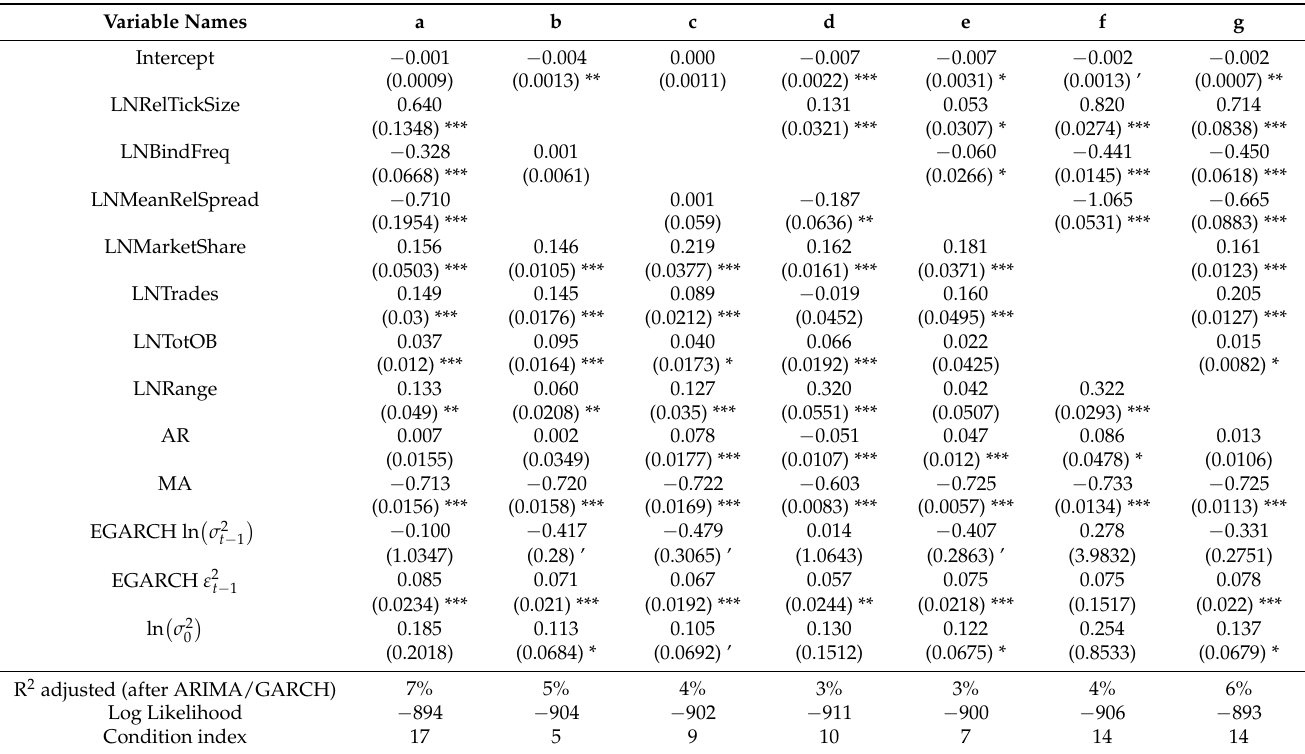
Table 5. Regressions on OIBReversal estimated with an ARIMA(1,1,1)-EGARCH(1,1) model. The regression is estimated with random effects in means and variance. Adjusted R 2 is calculated after normalization by ARIMA-GARCH and random effects. Robust time and group clustered standard errors are in brackets. The intraday data at one minute frequency are compiled to two month periods, resulting in 1557 observations and 1098 degrees of freedom after subtraction for random effects and parameters. Standard errors in